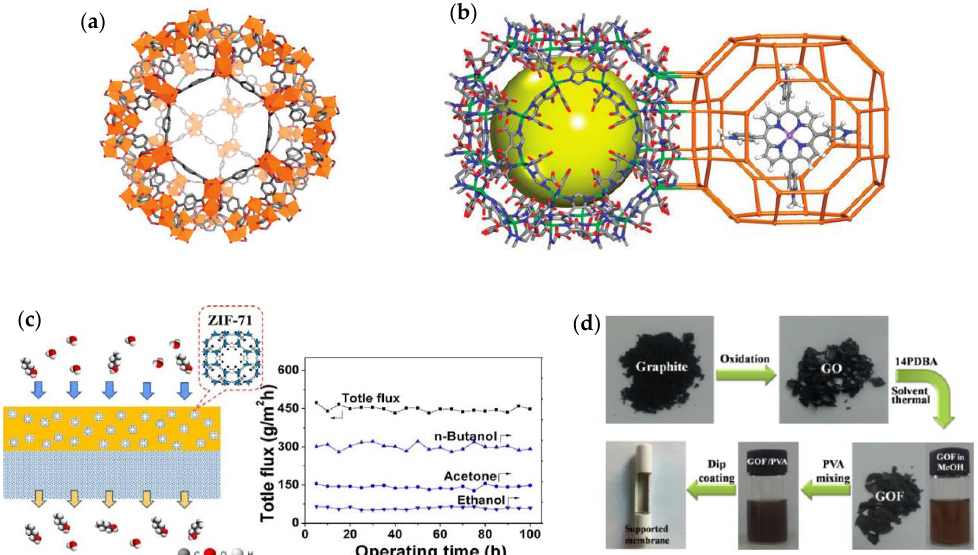
Figure 5. ( a ) Pore structure of MIL-101, ( b ) pore structure of rho-ZMOF (left) and encapsulated [H 2 TMPyP] 4+ porphyrin in RHO-ZMOF a-cage (right). Reproduced with permission from [70], published by Royal Society of Chemistry, 2009. ( c ) Mass transport of ZIF-71 incorporated membrane and its performance. Reproduced with permission from [55], published by Elsevier, 2013. ( d ) GOF/PVA MMM fabrication. Reproduced with permission from [58], published by Royal Society of Chemistry, 2015.